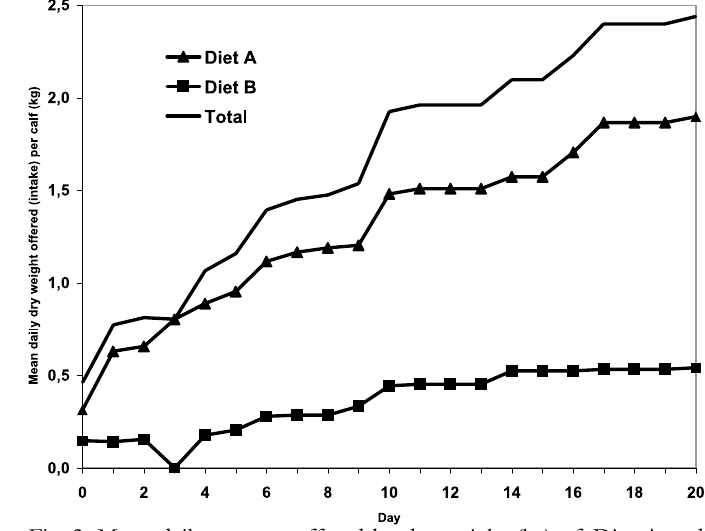
Fig. 2. Mean daily amount offered by dry weight (kg) of Diet A and Diet B pellets to calves during captivity on South Georgia. This is regarded as equivalent to mean daily intake (see text). Day zero refers to the day when the first calves were captured (13 January 2001) and Day 20 is the day prior to departure from South